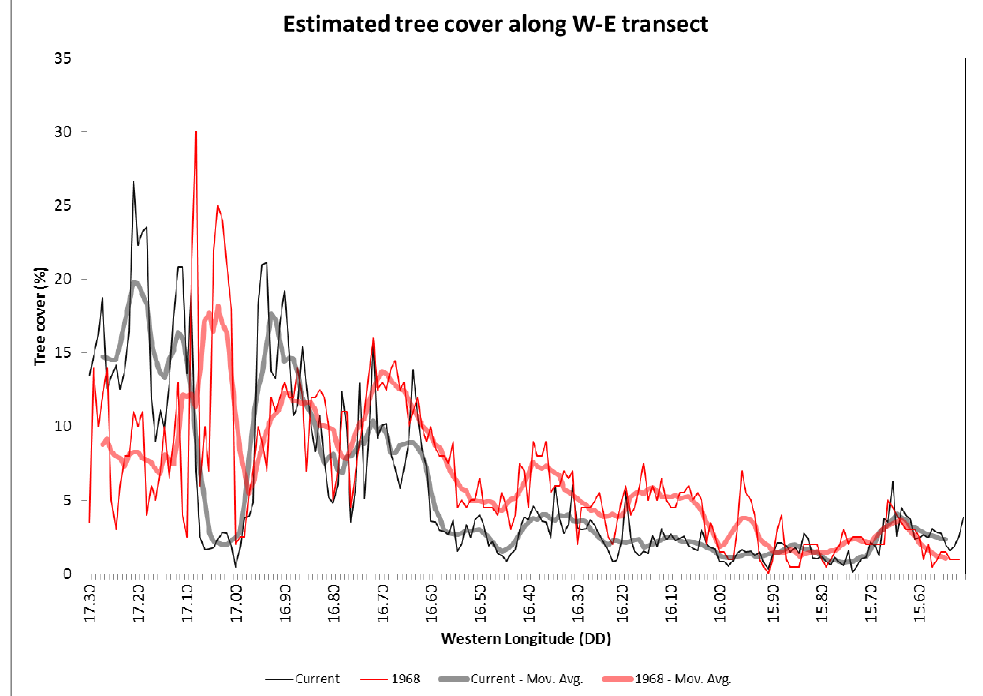
Figure 8. West-east transect of tree cover at 14.75°N. The current tree cover was modeled (see paragraph 2.4), and the 1968 tree cover was estimated visually from Corona images. The thicker lines represent 7-sample moving averages (averages of the data from point N − 3 to point N + 3 at each point N) of the original